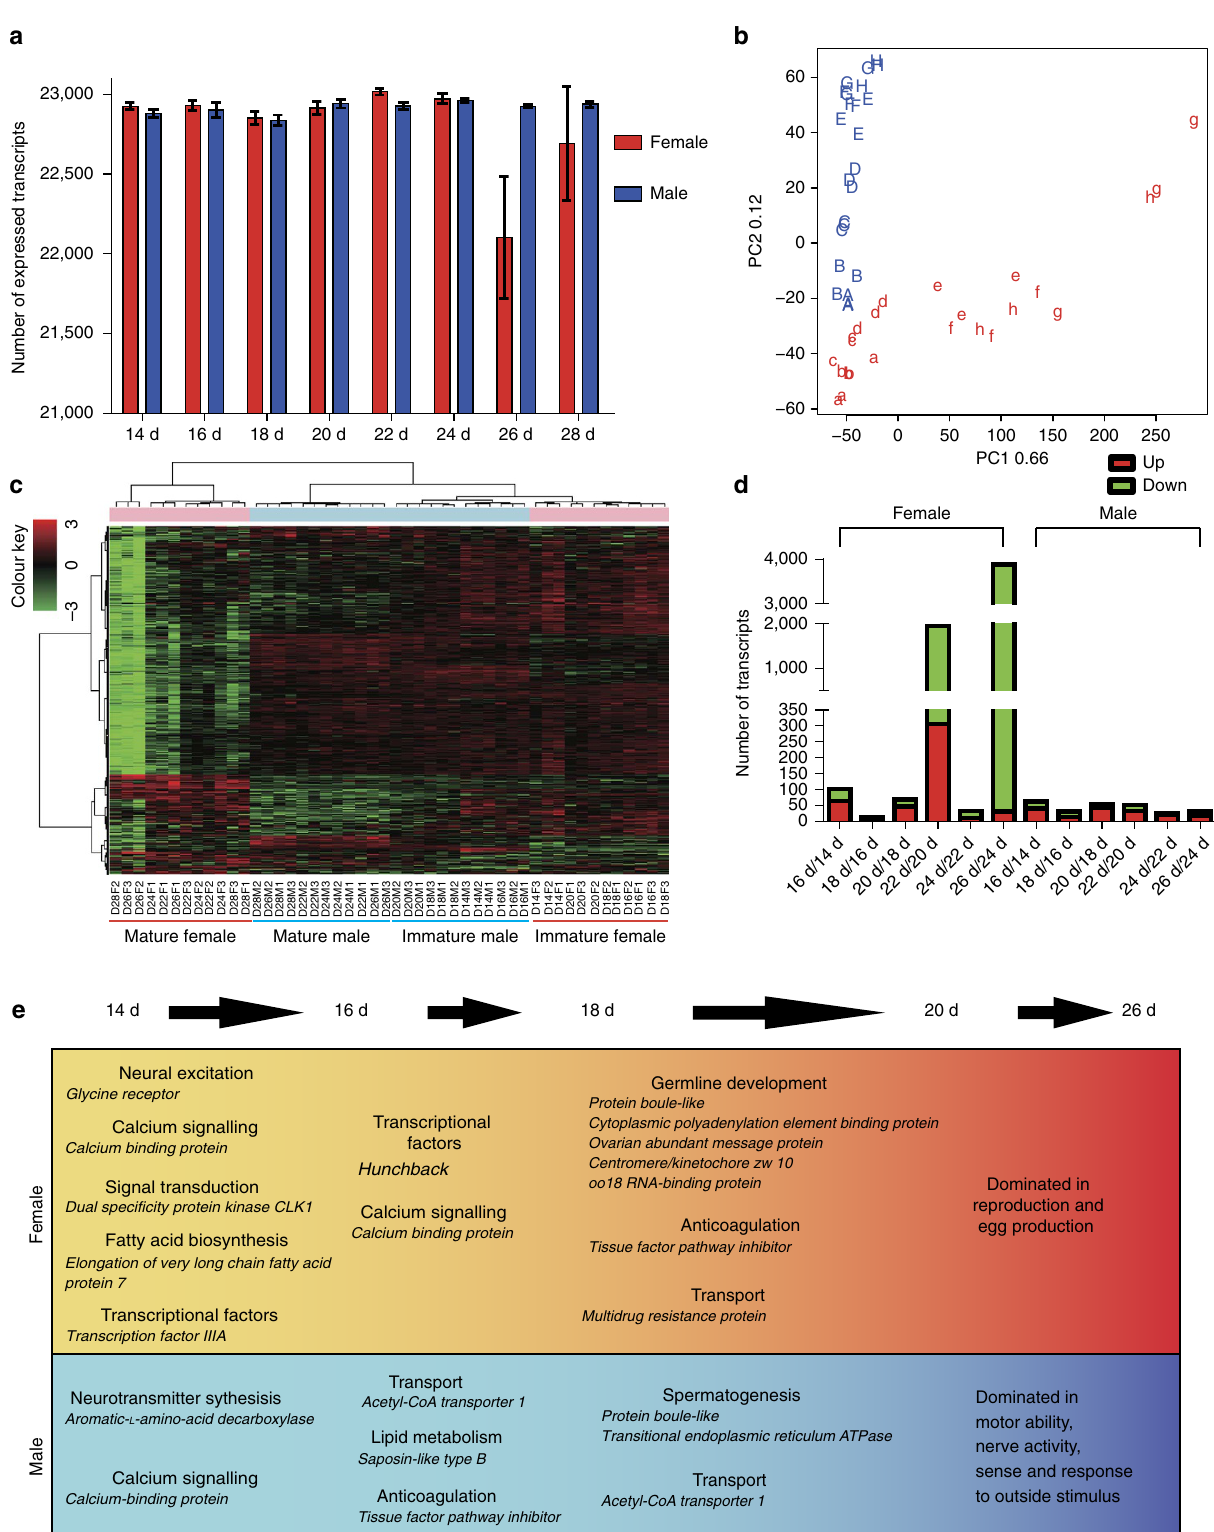
Figure 2 | Landscape of the transcriptome of S. japonicum . ( a ) Number of expressed genes (RPKM Z 1) detected across developmental stages in both males and females (mean ± s.e.m., n ¼ 3). ( b ) Principal components analysis (PCA) of a RNA-seq data set of 48 samples. A–H (a–h): 14–28 d.p.i. male (female). ( c ) Hierarchical clustering analysis (HCA) of transcriptional profiles from 48 S. japonicum samples with 23,099 genes. F, female; M, male. ( d ) Numbers of differentially expressed transcripts at adjacent time points based on a combination of Student’s t -test with Bonferroni-corrected P o 0.05 and a FC Z 2 (or r 0.5). Up, upregulated based on FC Z 2; down, downregulated based on FC r 0.5. ( e ) The enhanced molecular events in male and female worms from day 14 to 26 after infection of the skin by the